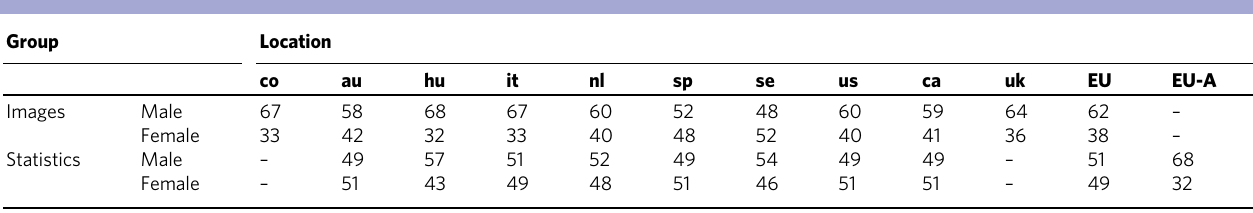
Table 3 Comparison between estimated distributions per location and statistics about migration and gender for selected